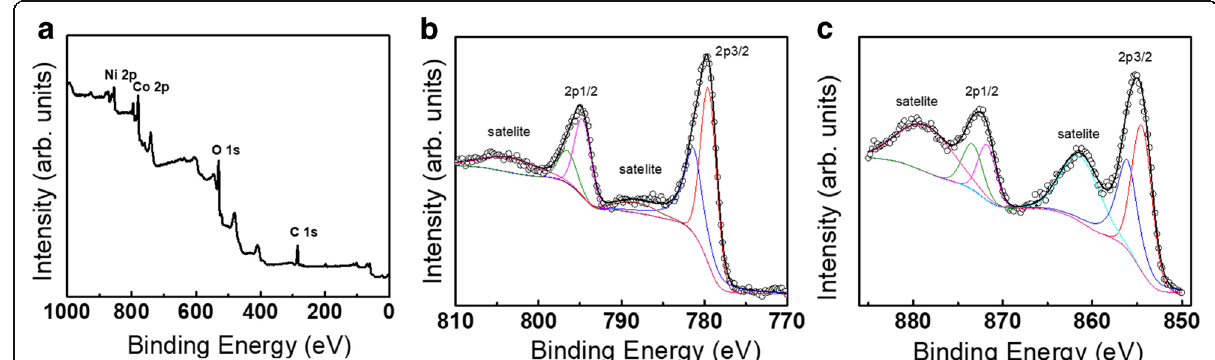
Fig. 6 a Survey spectrum of sea urchin-like NiCo 2 O 4 . b , c High-resolution XPS spectra of Co2p and